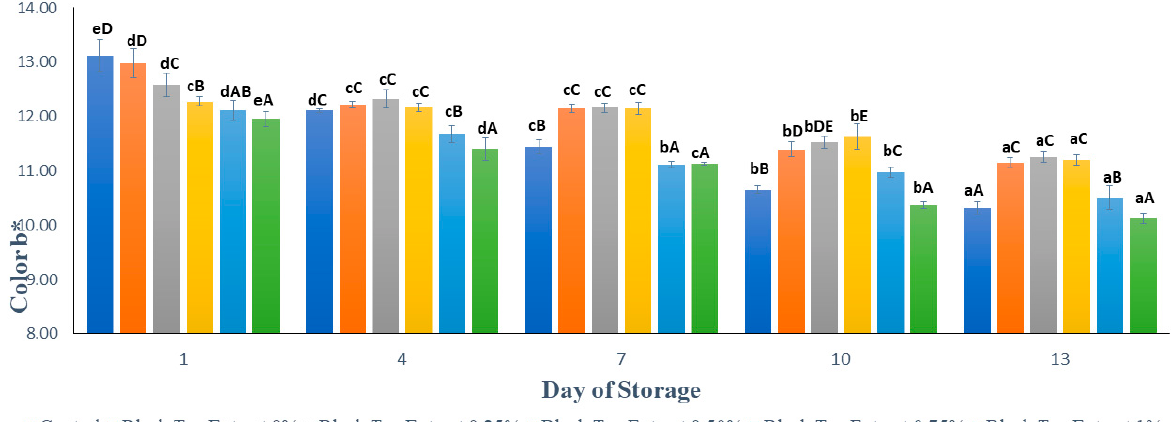
1% black tea extract.